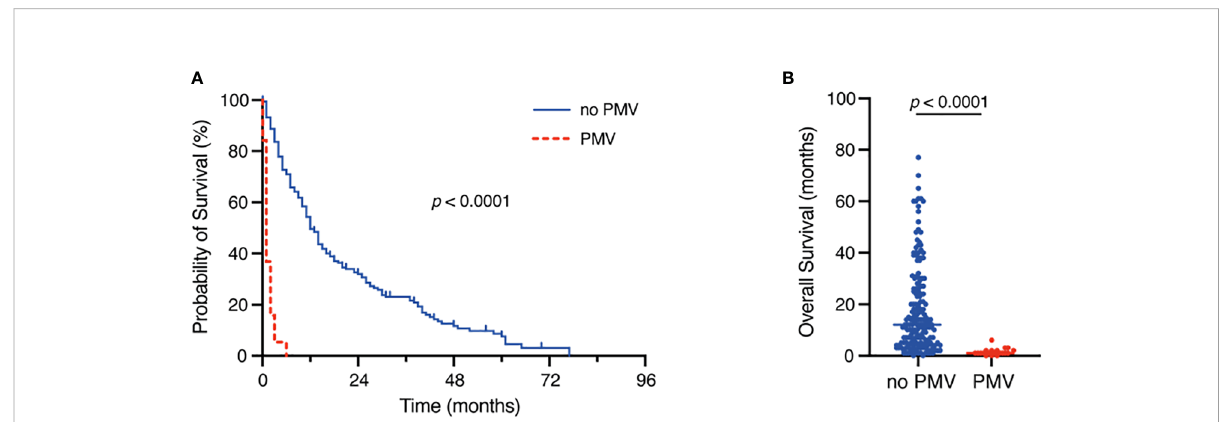
FIGURE 1 Kaplan-Meier survival analysis (A) and dot plots (B) dependent on the occurrence of postoperative PMV. PMV, prolonged mechanical